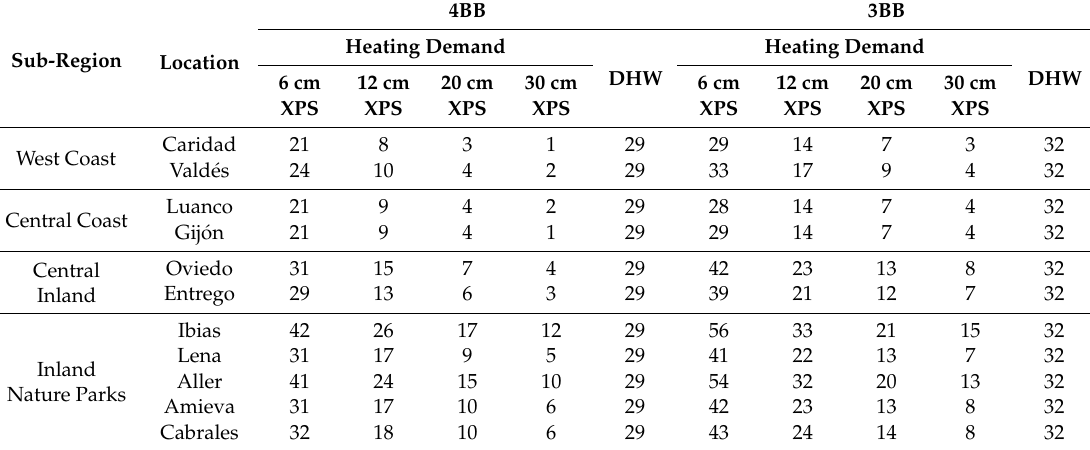
Table 8. Heating and domestic hot water demand for the locations and insulation